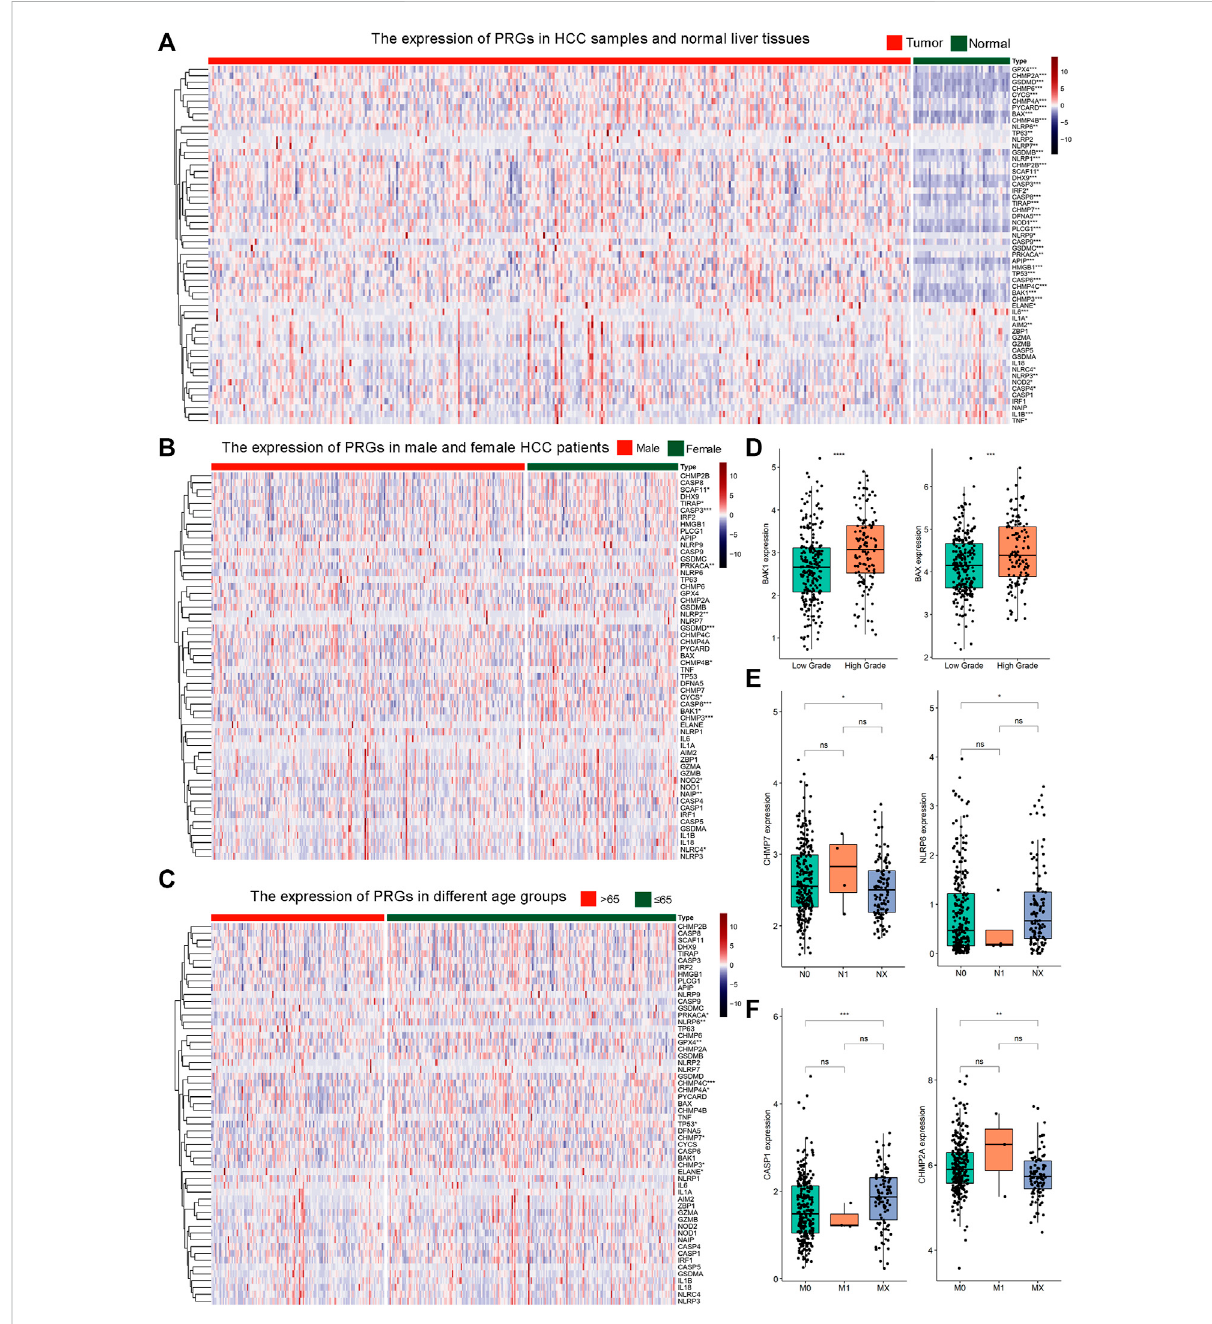
FIGURE 1 The expression pro fi le of 56 pyroptosis genes in HCC. (A) Heat map illustrating the expression of 56 pyroptosis genes in HCC samples and normal liver tissues. The color from blue to red indicates a transition from low expression to high expression. * Means p < 0.05, ** means p < 0.01, ***means p < 0.001 (the same below).; (B) Heat map of the expression of 56 pyroptosis genes in male and female HCC patients; (C) Heat map of the expression of 56 pyroptosis genes in HCC patients of different age groups. The green color indicates patients ≤ 65 years old. The orange color indicates patients > 65 years old. (D) The expression of BAK1 and BAX in HCC samples with low or high histologic grade. (E) The expression of CHMP7 and NLRP6 in HCC patients with N0, N1, or NX. (F) The expression of CASP1 and CHMP2A in HCC patients with M0, M1, or